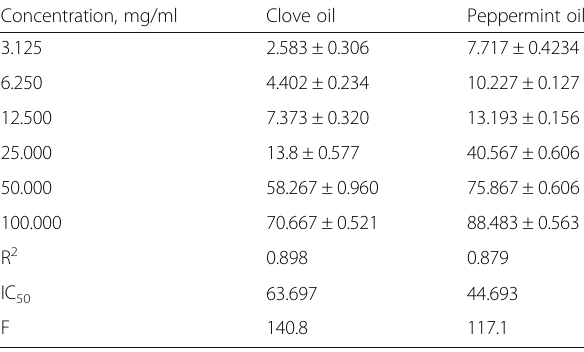
Table 3 Gtf inhibitory effect of clove and peppermint oils at various